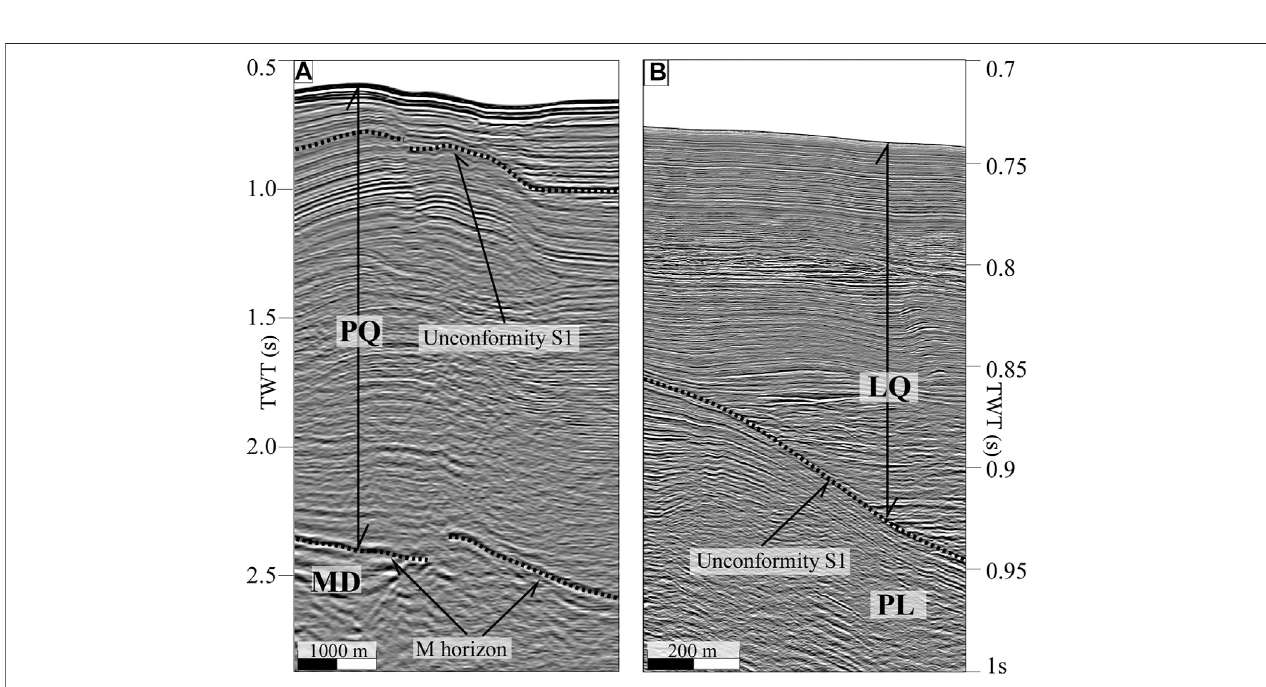
FIGURE 4 | (A) Seismostratigraphic units (MD and PQ) recognised on the high-penetration seismic pro fi le “ Line Sister — 12 ” . (B) Seismostratigraphic subunits (PL and LQ) recognised on the HR seismic pro fi le “ Line — 04. ” See Figure 5A for location.